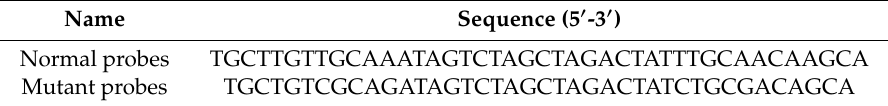
Table 5. Normal and mutant probes for POU2F1 .